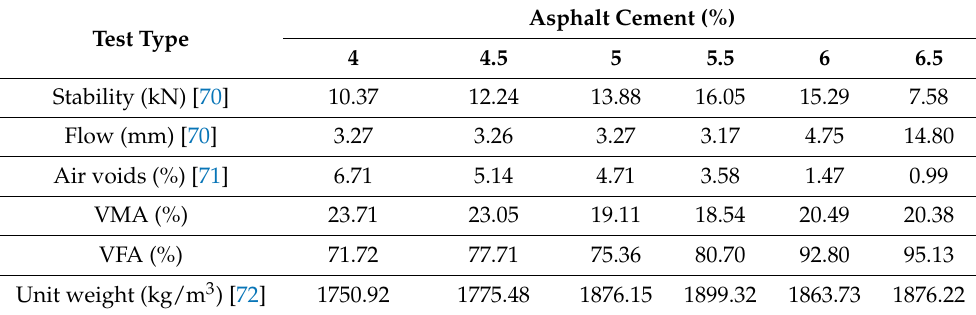
Table 3. Test results for the mix prepared with limestone